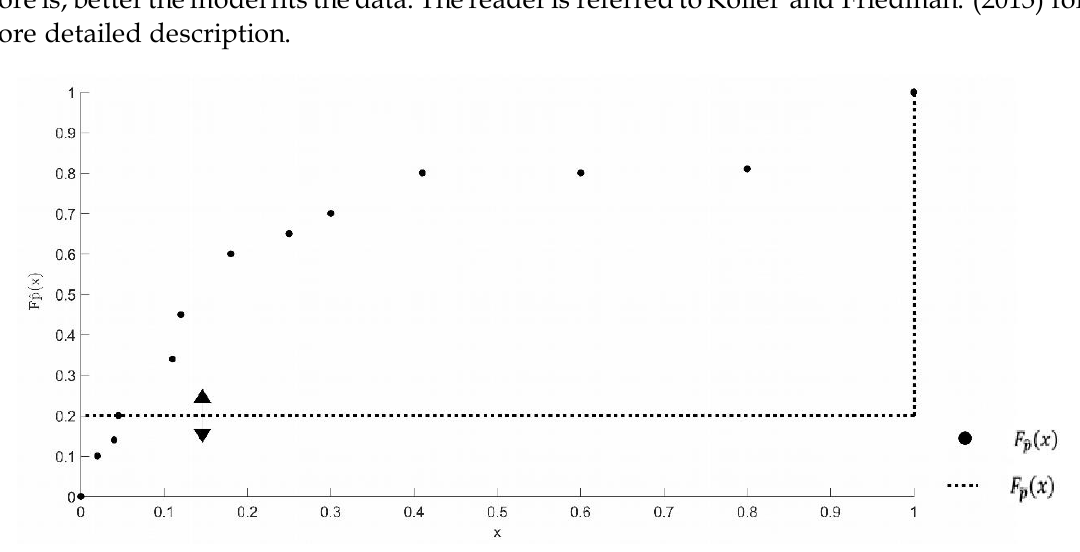
Figure 1. Empirical cumulative distribution functions 𝐹